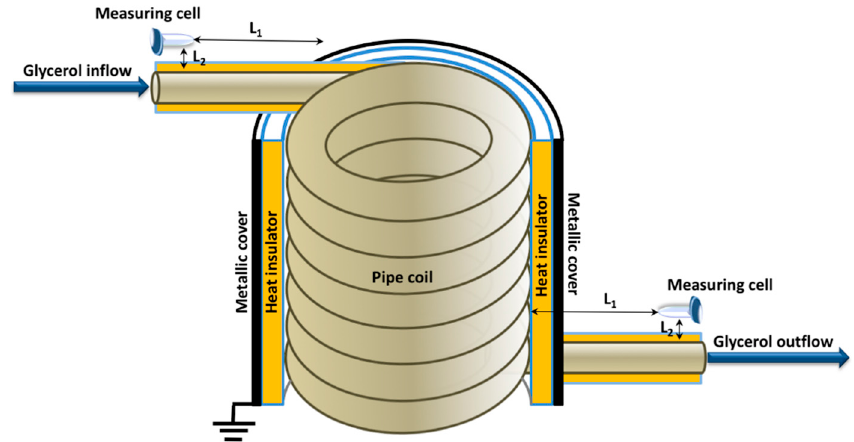
Figure 1. Schematic representation of the experimental setup employed for studying the effect of liquid flow on the properties of a protein. The measuring cell with the enzyme solution was placed near either the inflow or the outflow linear section of the silicone pipe, whose central section forms a coil. The coil is shielded with a grounded metallic cover. Glycerol is pumped through the pipe.